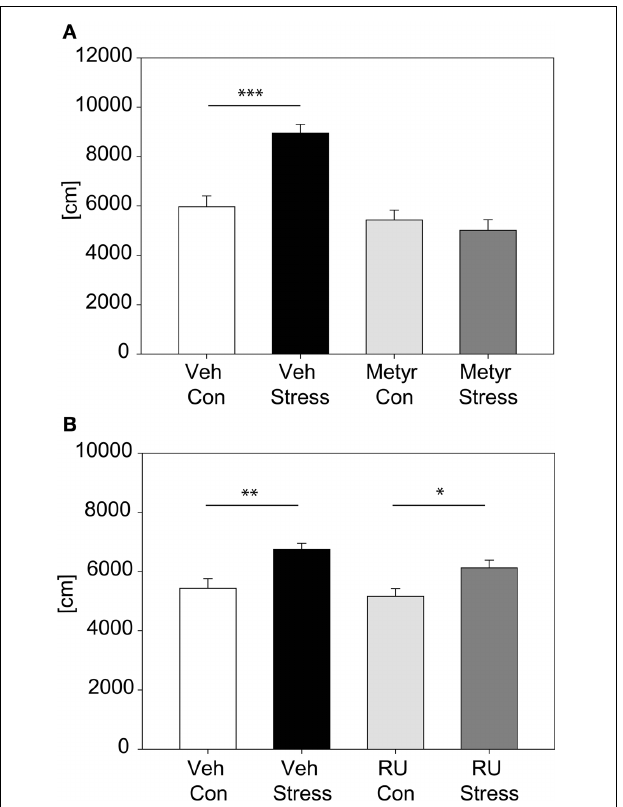
FIGURE 5 | Pharmacological analysis of corticosterone feedback. Graph (A) shows the distance traveled in the first 5min of the OF with animals treated with Metyrapone or vehicle. Statistics revealed a significant interaction and post hoc tests demonstrated that only in the vehicle-treated animals the expected increase after stress occurred. Graph (B) depicts the distance traveled in the first 5min of the OF with animals treated with either RU486 or vehicle. Vehicle-treated as well as RU486-treated animals show an increase in activity after 2h of stress. Error-bars shown as s.e.m.; Significances: ∗ p ≤ 0 . 05; ∗∗ p ≤ 0 . 01; ∗∗∗ p ≤ 0 . 001; n = 11–15 per